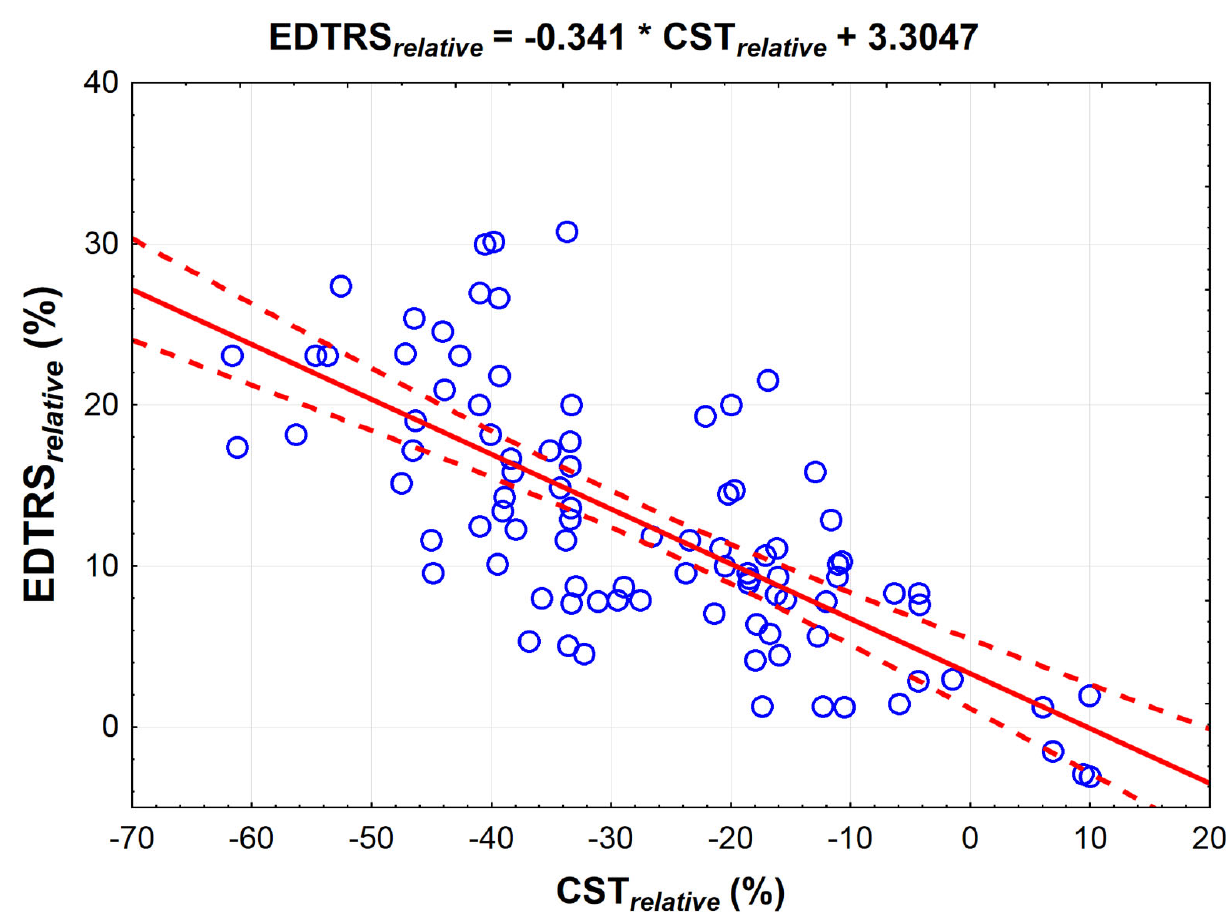
Figure 2. Linear regression between relative best-corrected visual acuity (BCVA relative ) and relative central subfield thickness (CST relative ) in patients with diabetic macular edema (DME) enrolled in the study ( n = 98). Dashed lines denote 95% confidence interval.